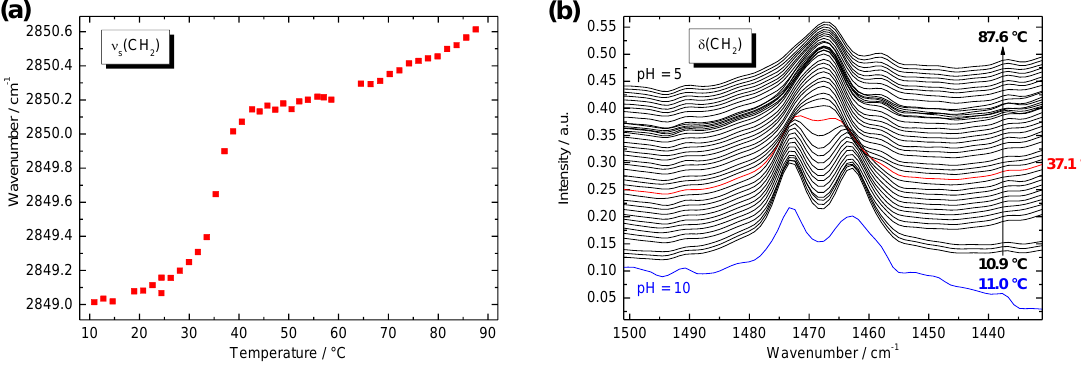
T e m pe r a t u r e / ° C Figure 6. Fourier transform infrared (FTIR) spectroscopy data of Me 2 PE-Gly(2C16)C32-OH ( c = 100 mg mL −1 in acetate buffer, pH = 5, 300 mM): ( a ) wavenumber of the symmetric methylene stretching vibrational band as a function of temperature; and ( b ) FTIR spectra at different temperatures in the region of the methylene scissoring vibrational band; in black: heating from 10.9 °C (bottom) to 87.6 °C (top) in acetate buffer at pH = 5.0 with increments of 2 K (the red curve at 37.1 °C indicates a change in the band positions); in blue: FTIR spectrum in carbonate buffer at pH = 10 at 11.0 °C. The individual curves are shifted vertically for clarity.